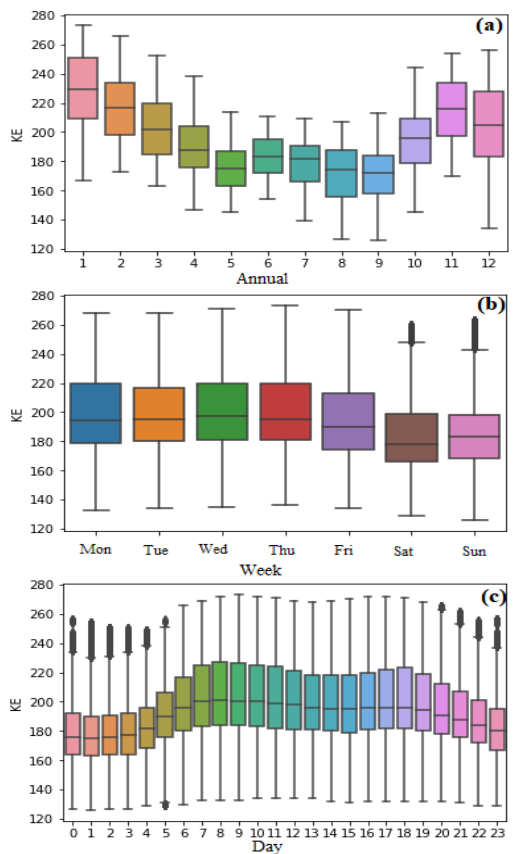
Figure 5. Seasonal variations of KE: ( a ) annual, ( b ) weekly, and ( c ) daily.